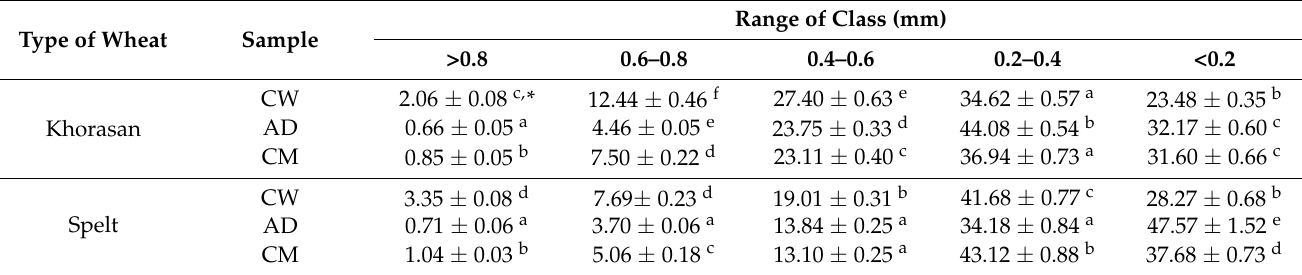
Table 2. Particle size distribution of ground wheat